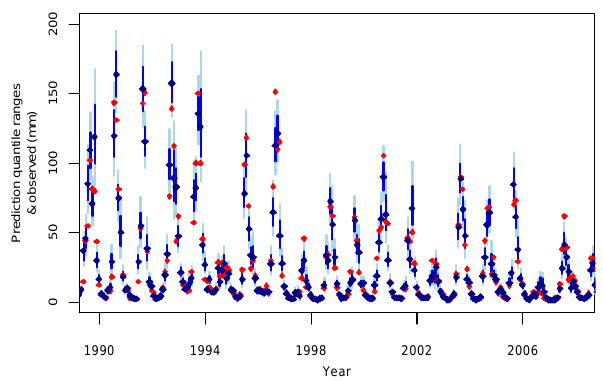
Fig. 2. The time series of the post-processed prediction quantiles against the observed; only a subset of the entire cross validation period is shown ( Light blue lines represent 0.1–0.9 quantiles, dark blue lines represent the 0.25–0.75 quantiles, and blue dots represent the medians of the post-processed predictive distributions. Red dots are the observed streamflow values. ).